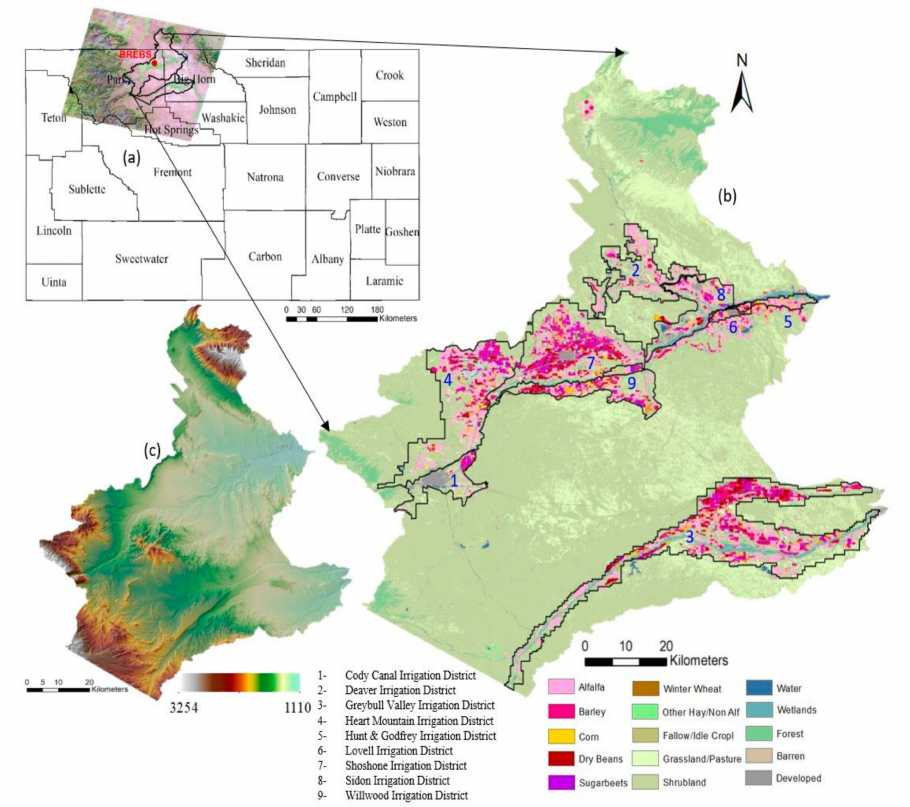
Figure 1. Location map of the study area within the Big Horn Basin (BHB) Wyoming ( a ) Landsat Path 37 Row 29 footprint along with county map and location of Bowen Ratio Energy Balance System (BREBS) ( b ) Land use map with irrigation district boundaries of nine irrigation districts within the study area ( c ) elevation (meters) with hill shade e ff ect underneath